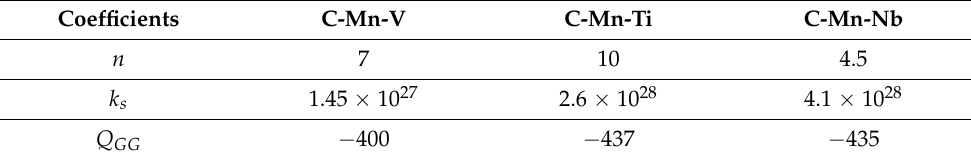
Table 5. Parameters used in the grain growth calculation when complete recrystallization takes place. These parameters were obtained by Hodgson and Gibbs [10] for three types of